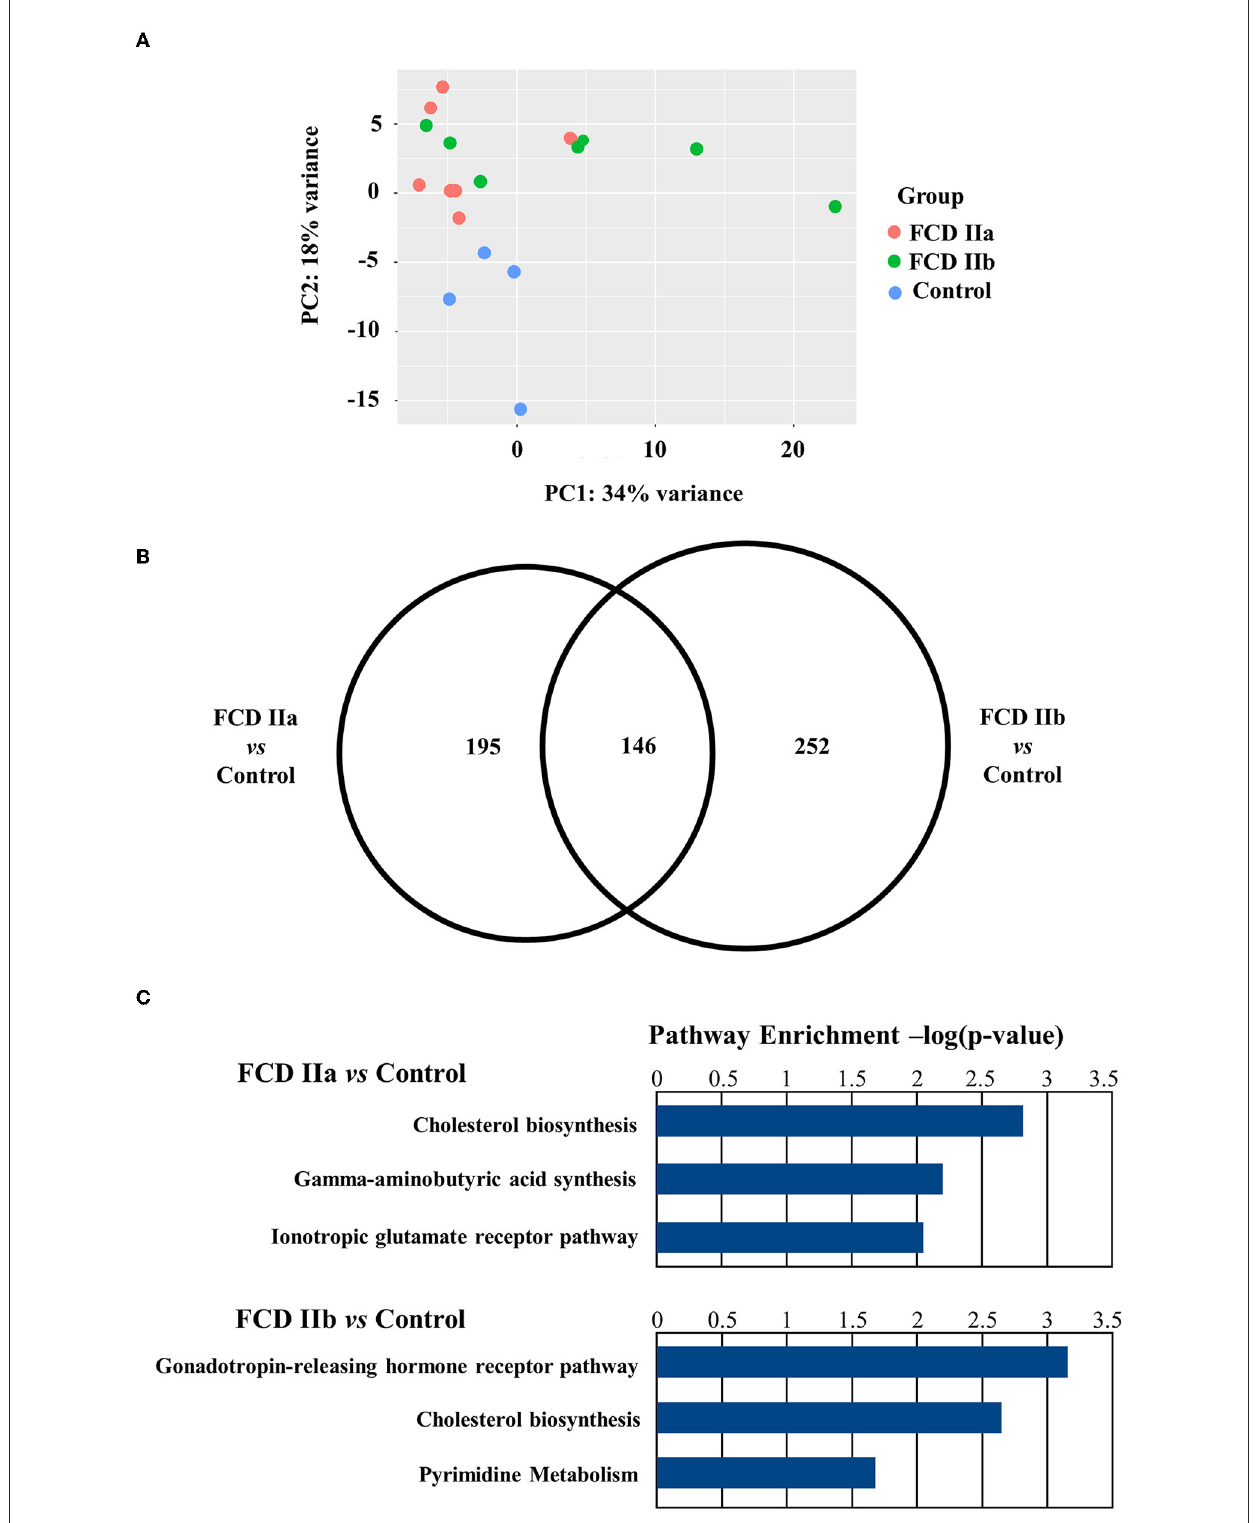
FIGURE3 Gene expression analyses of the gray matter (cortical layer) of autopsy (control), focal cortical dysplasia (FCD) ILAE type IIa (FCD IIa) and FCD ILAE type IIb (FCD IIb) samples. (A) Graphical presentation of gene expression data after analyses performed with the PCA dimensionality reduction method. Brazilian and German FCD specimens with the same histopathological classification are shown as one group (FCD IIa or FCD IIb). Note that the majority of FCD IIa samples tended to group together, as observed for FCD IIb cases. Each circle corresponds to an individual sample. (B) Venn diagram showing the number of differentially expressed genes in each group compared to controls. FCD IIa and FCD IIb groups showed 342 and 399